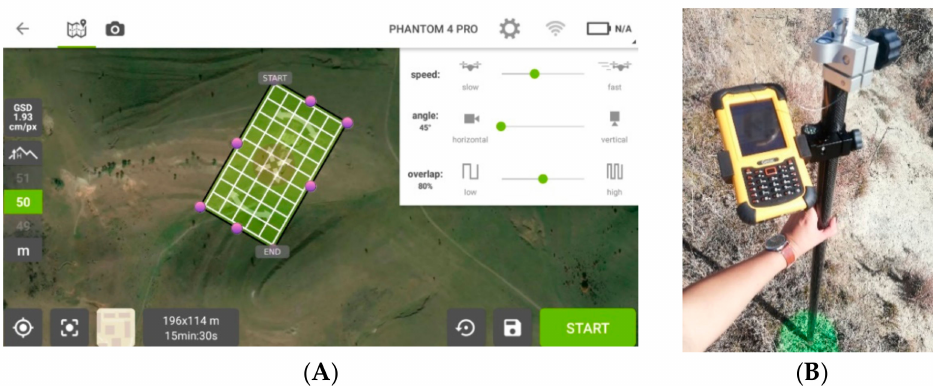
Figure 3. ( A ) Fly plan; ( B ) GCP and CP